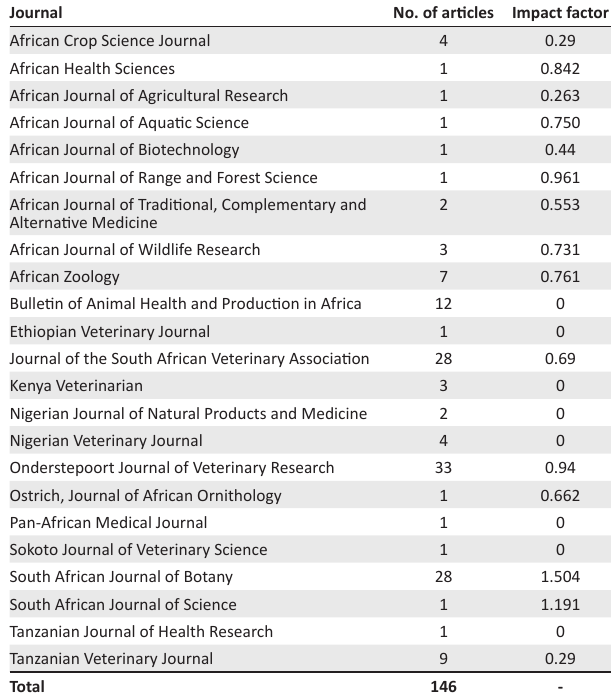
TABLE 3: Published research output ( n = 146) of 80 World Association for the Advancement of Veterinary Parasitology African Foundation travel scholarship recipients in 23 African